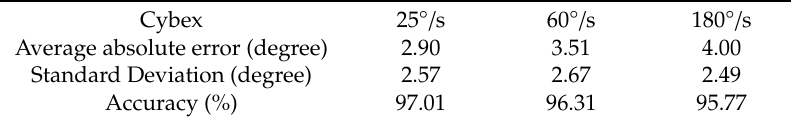
Table 5. Average errors for healthy control subjects at three angular speeds.